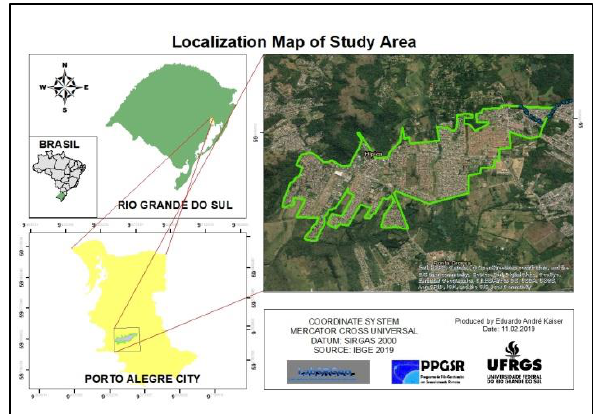
Figure 1. Location map of the urban area of districts Aberta dos Morros, Hípica and Restinga in the municipality of Porto Alegre, Rio Grande do Sul, Brazil. According to Köppen climate classification, the climate of Porto Alegre belongs to the subtype “Cfa”, with mean annual temperature of 19.5 °C and annual rainfall of 1300 mm (Ferraro, 1995).